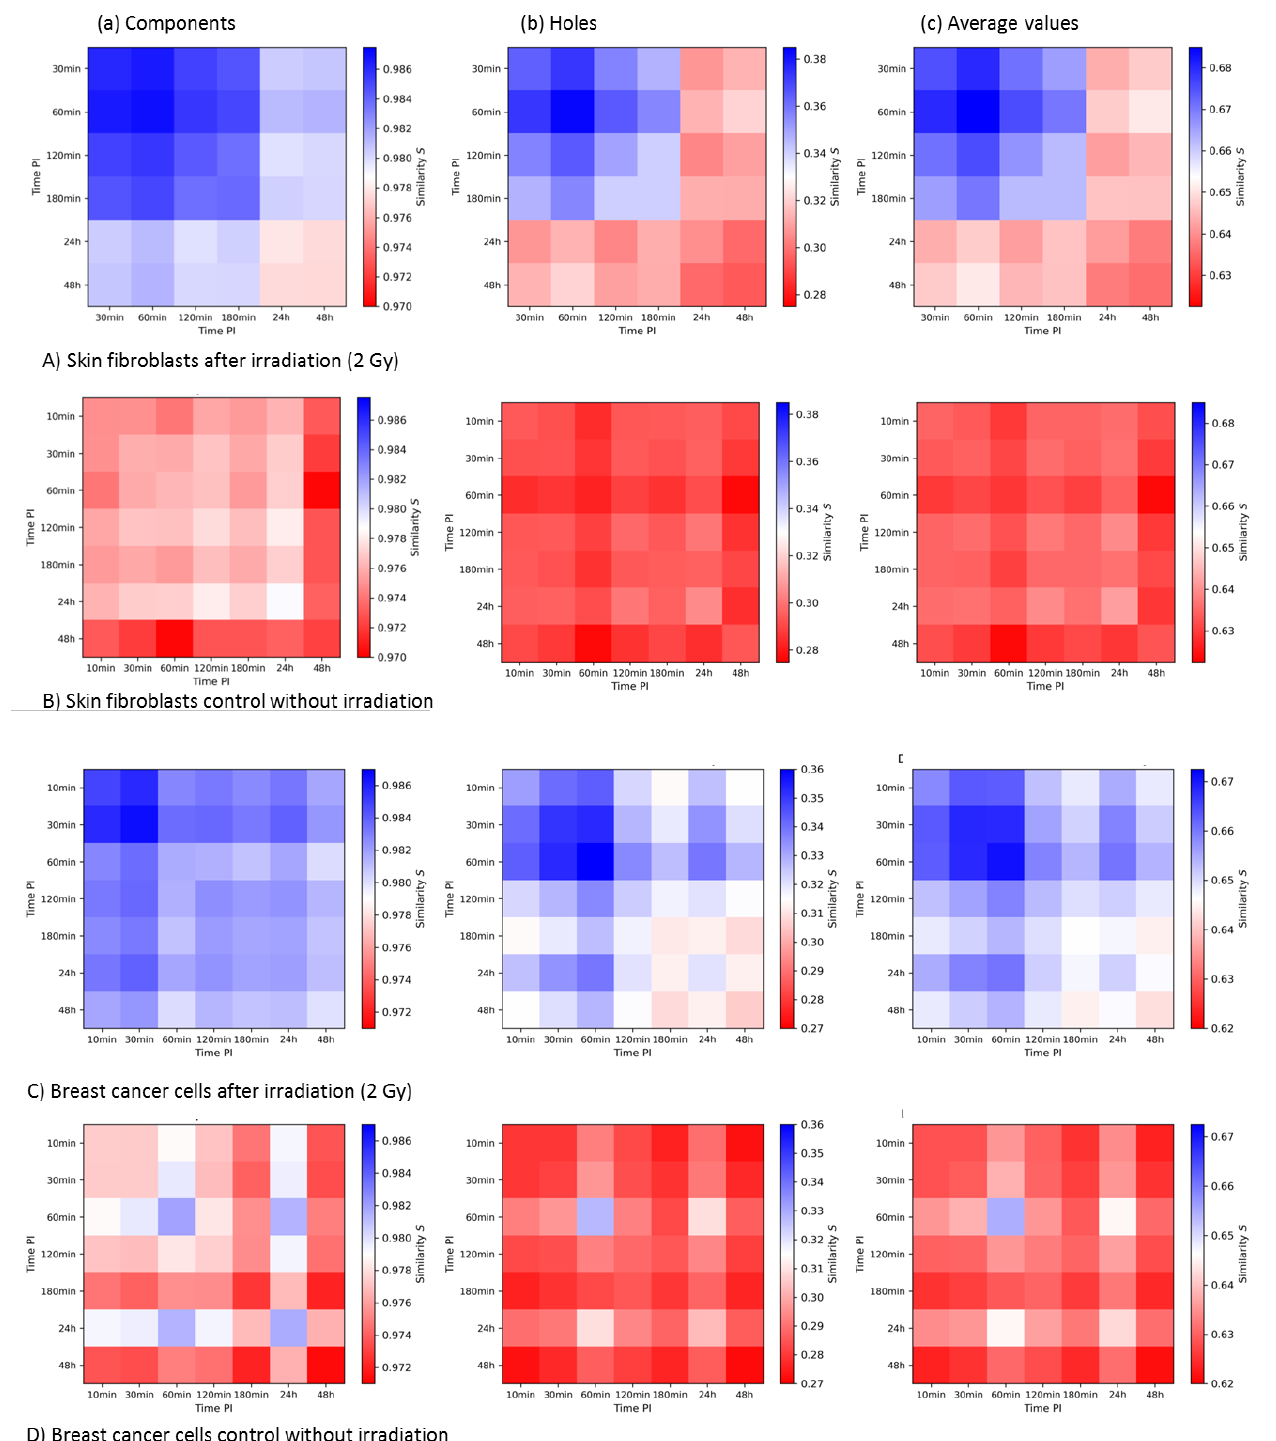
Figure 7. Second-generation heatmaps of γ H2AX clusters of components ( a ) and holes ( b ) and average values of both ( c ) for the skin fibroblast cell line CCD-1059SK ( A , B ) and the breast cancer cell line MCF-7 ( C , D ). Each value of a pixel of these heatmaps represents the mean value of one 1st-generation heatmap. Note the differences in the color bars between ( a – c ), while the visual pattern may be similar.